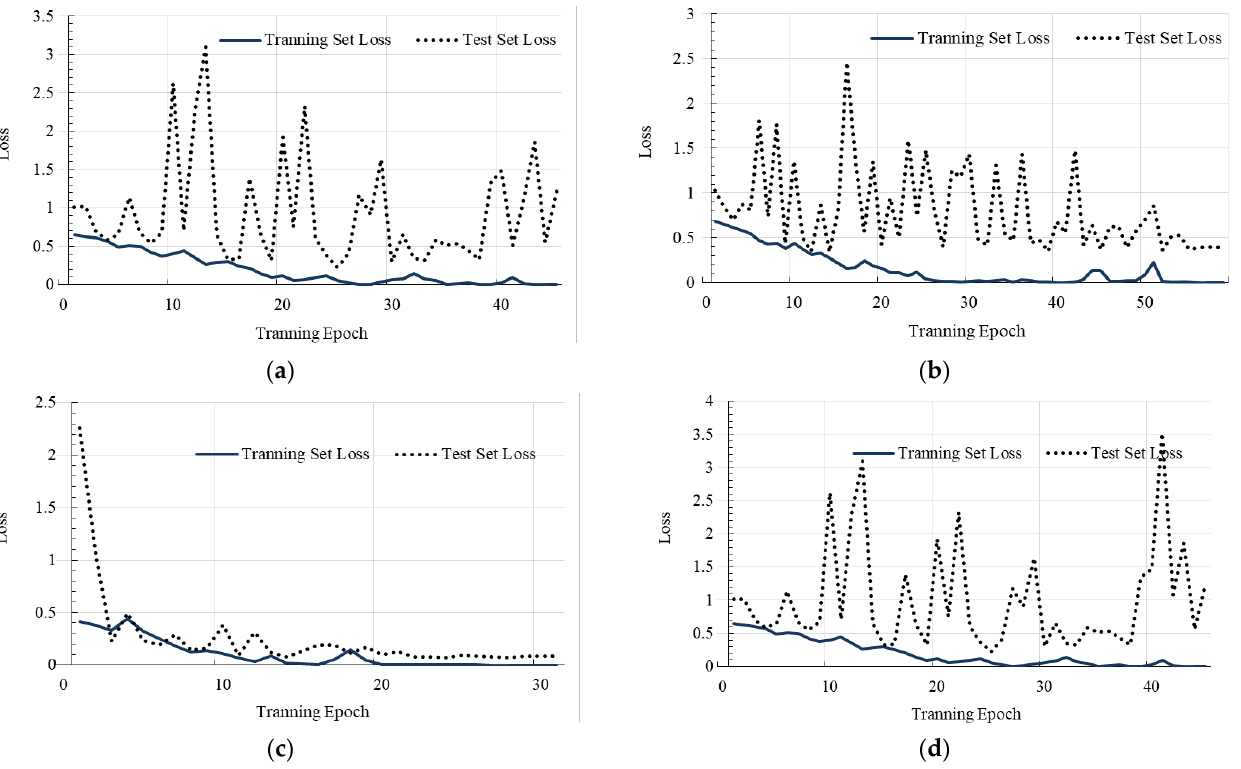
Figure 9. Loss plot of training and test sets of four different emotions in RAVDESS dataset for Stage 2 (Intensity Measure) in Cascaded DL framework. ( a ) Happy Emotion; ( b ) Sad Emotion; ( c ) Angry Emotion; ( d ) Fearful Emotion.